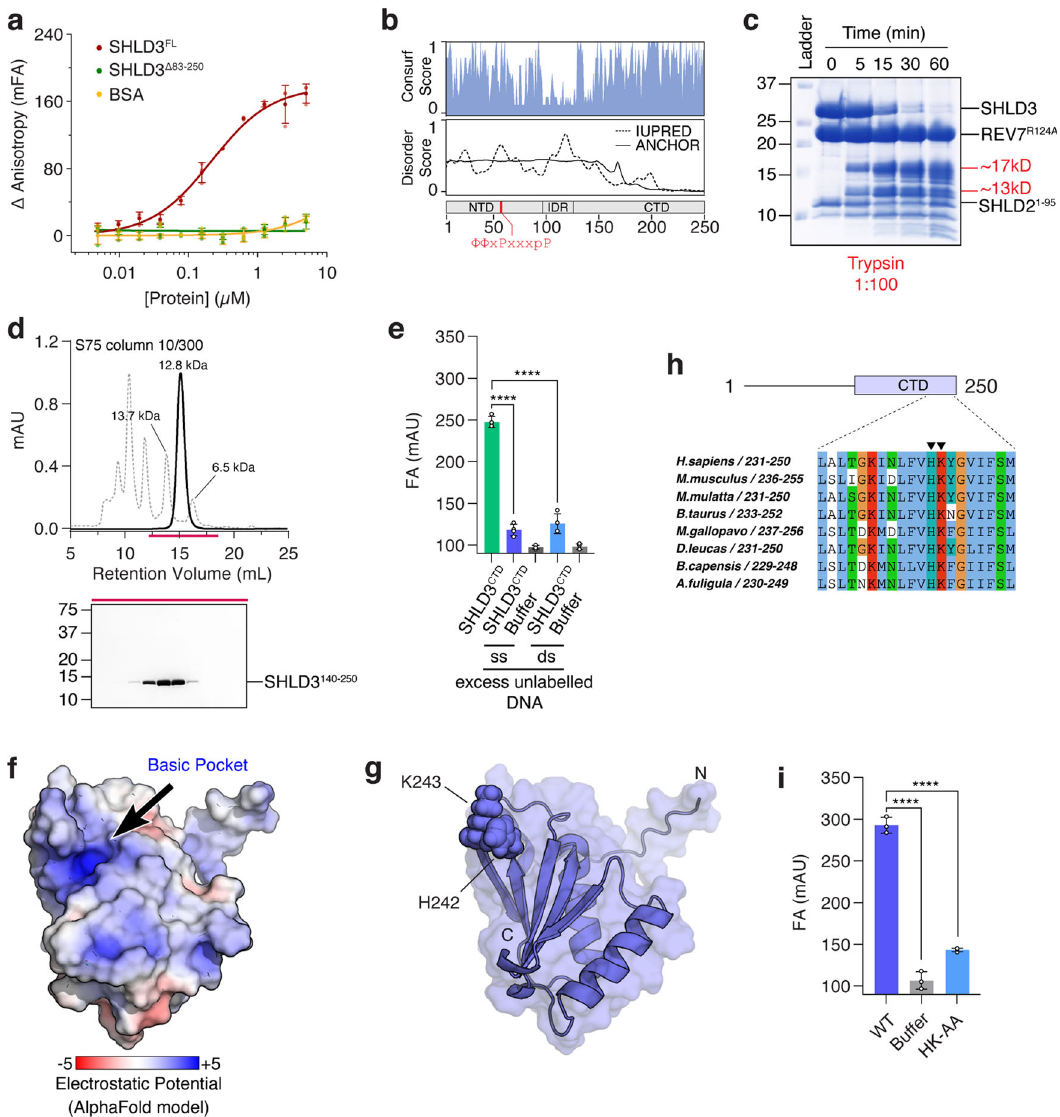
Fig. 2 SHLD3 C-terminus contains a DNA binding domain. a Fluorescence anisotropy measurement of different constructs of Shieldin complex for binding af fi nities against ssDNA (Supplementary Tables 1, 2). Shieldin complex with deletion of SHLD3 residues 83 – 250 is de fi cient in DNA binding. Brown line represents Shieldin complex, green line represents Shieldin complex Δ SHLD3(83-250) , yellow line represents BSA. Error bars represent s.d. ( n = 3 independent experiments). b Disorder prediction of SHLD3 using IUPRED shows that the N-terminal region (1 – 150) is disordered while the C-terminal region is folded. The sequence conservation score shows increased conservation in the N-terminal region (1 – 83) and C-terminal region (140 – 250). c Proteolytic digestion of the Shieldin complex with trypsin shows degradation of SHLD3 to stable fragments of roughly 17 kDa and 13 kDa. d Puri fi cation of SHLD3 140 – 250 by size-exclusion chromatography. e FA competition assay shows SHLD3 CTD binds ssDNA and dsDNA without preference (Supplementary Tables 1, 2). FAM-labeled ssDNA at 10 nM was incubated with 1 µ M SHLD3 CTD . Labeled ssDNA was competed out using either 1 µ M non-telomeric ssDNA or dsDNA. Error bars represent s.d. ( n = 4 independent experiments). Two-tailed Student ’ s test are indicated: **** p < 0.0001. f Surface electrostatic analysis of the SHLD3 CTD AlphaFold2 model reveals presence of an electropositive patch. g SHLD3 CTD shown in surface representation with H242 and K243 shown as spheres. h Residues H242 and K243 are conserved across SHLD3 homologues in higher eukaryotes. Sequence alignment was performed with Clustal package in Jalview 43 . Residues are colored according to Clustalx scheme, where conserved residues are colored as follows: blue (hydrophobic), red (positively charged), orange (glycine), cyan (hydrophobic) and green (polar). i Introduction of H242A and K243A point mutants abolishes binding af fi nity of SHLD3 CTD to ssDNA (Supplementary Tables 1, 2). Experiment performed as in ( e